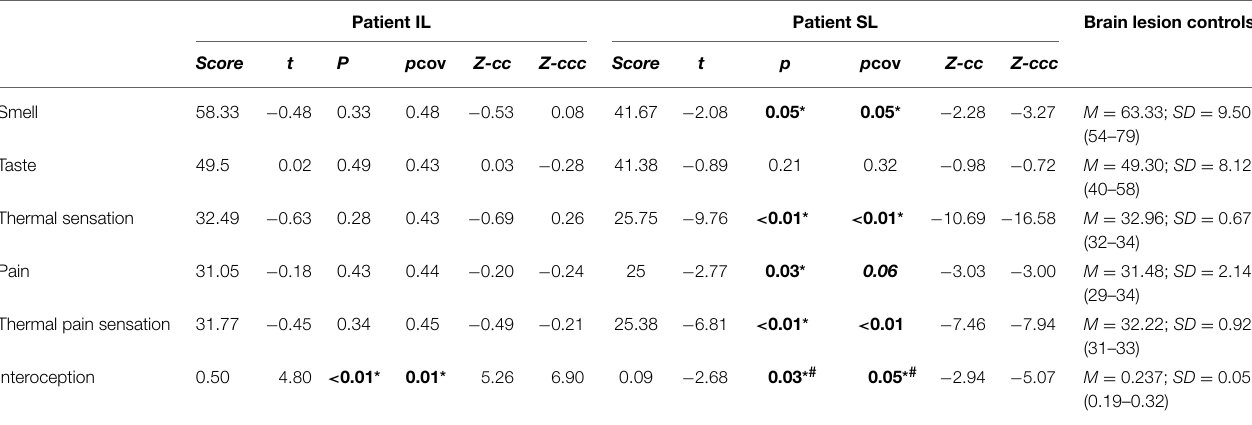
TABLE 5 | Results of comparing patient IL and SL with frontal damage patients. Patient IL Patient